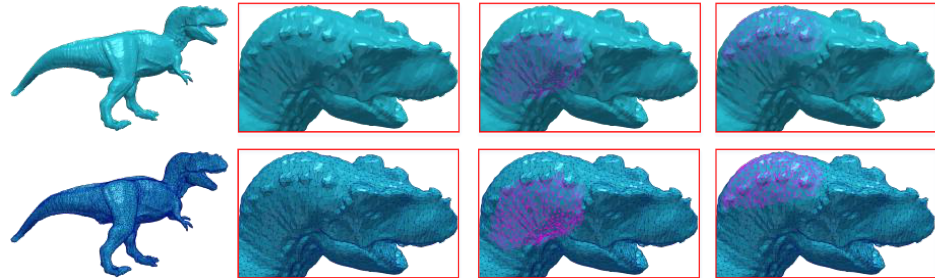
Figure 3. Overlapped parts means that each boundary point belongs to more than one part and its degree may vary significantly between different parts.